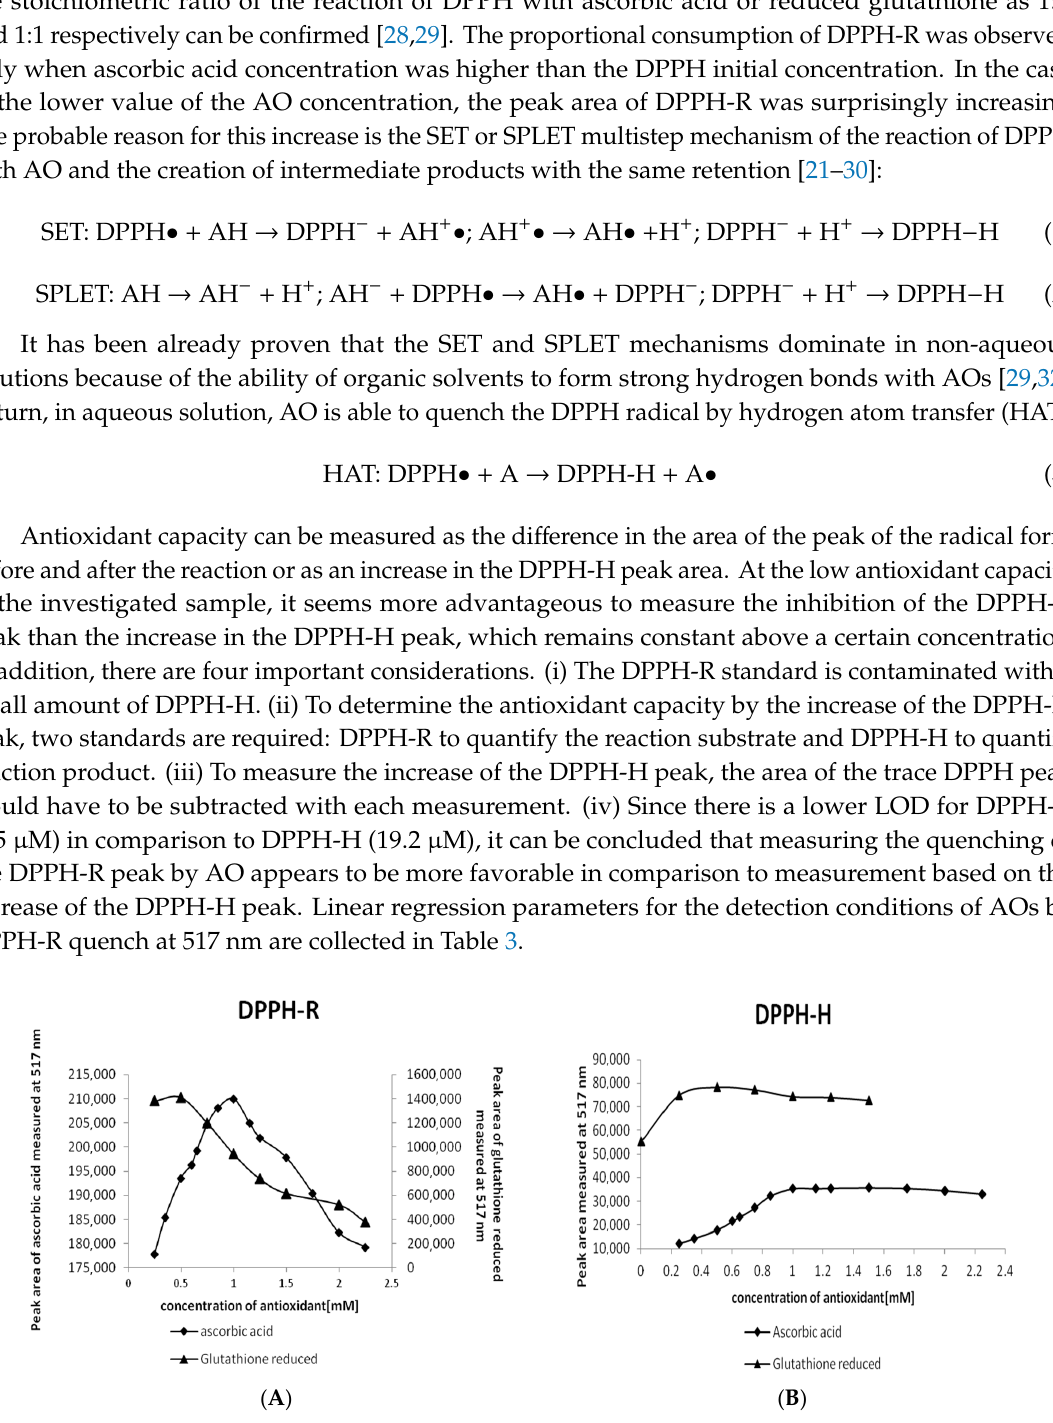
Figure 6. The surface areas of the DPPH-R ( A ) and DPPH-H ( B ) after reaction 1 mL of 1 mM DPPH with 1 mL of different concentrations of ascorbic acid and reduced glutathione dissolved in 80% ( v / v ) methanol measured by RP-HPLC-UV at 517 nm. 2.3. The Determination of the Antioxidant Capacity of Aegopodium podagraria L. Extracts by DPPH- HPLC-DAD